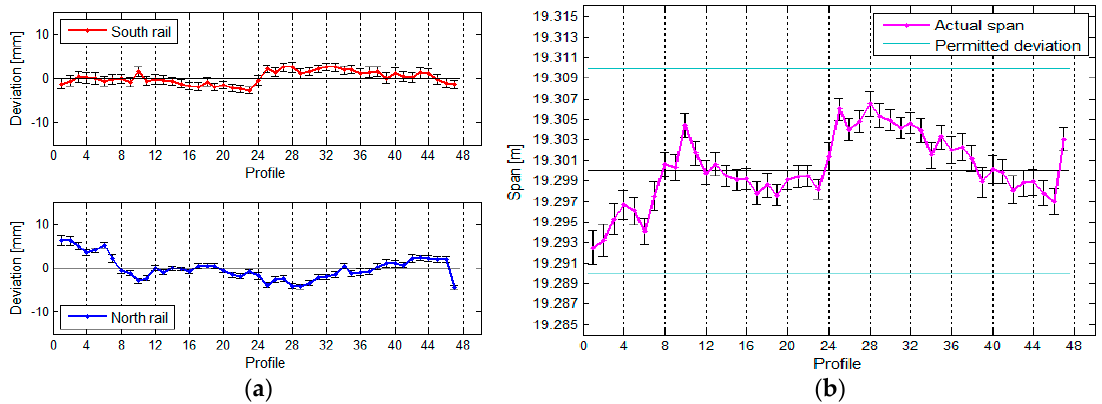
Figure 16. ( a ) The rails’ deviation and their positions, and ( b ) the span between the rails, with the standard deviations, for the crane in the TPP in Brestanica measured with TLS.